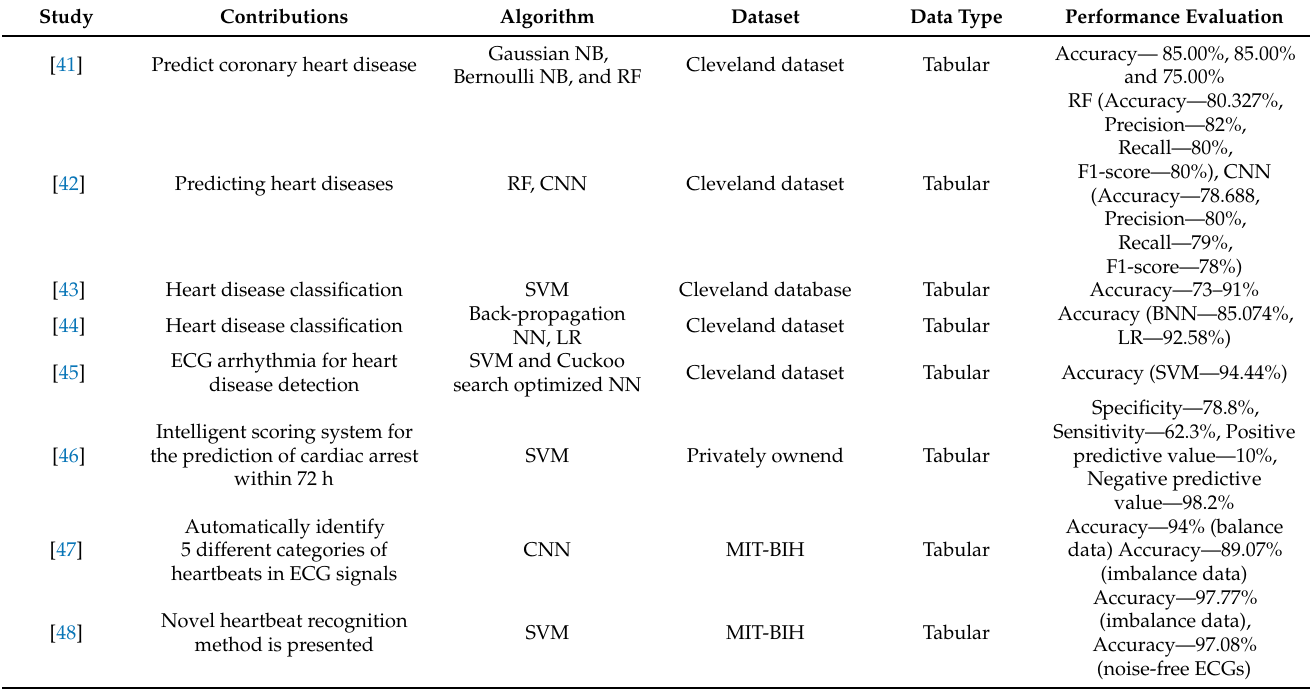
Table 3. Referenced literature that considered machine-learning-based heart disease